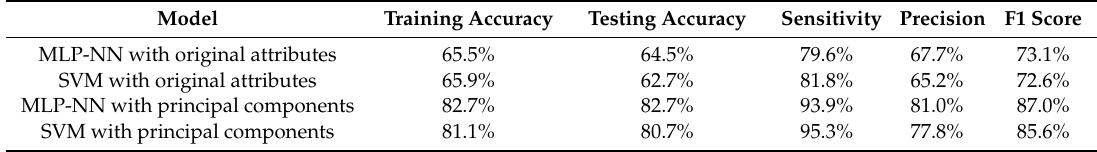
Table 4. Performance measures of the developed models (slight injury crashes).